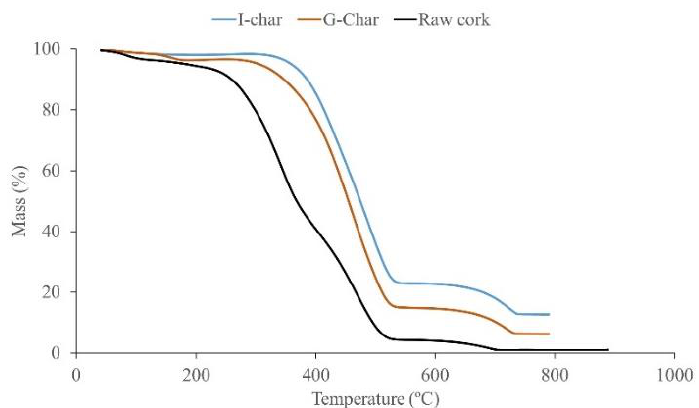
Figure 8. Combustion patterns of raw cork and non-isothermal biochars (G-char).